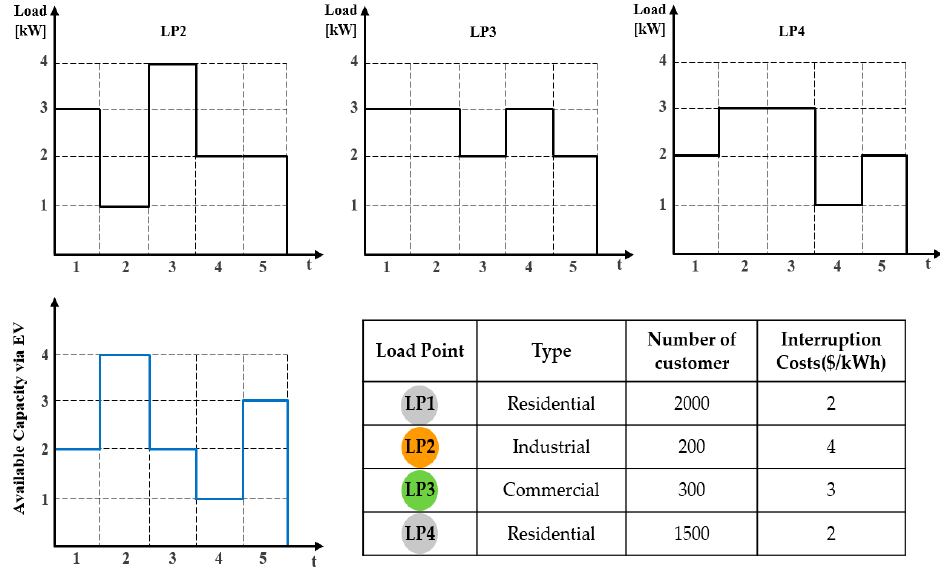
Figure 5. Information of the example system.